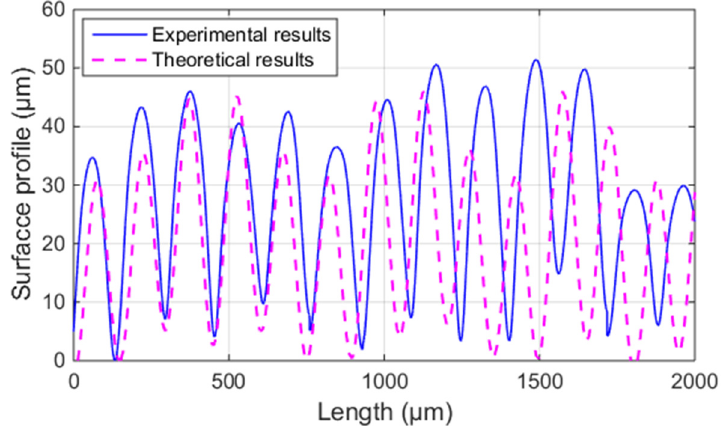
Figure 10. Theoretical and average experimental results of the surface profile of the ME samples vertical to the fiber direction.